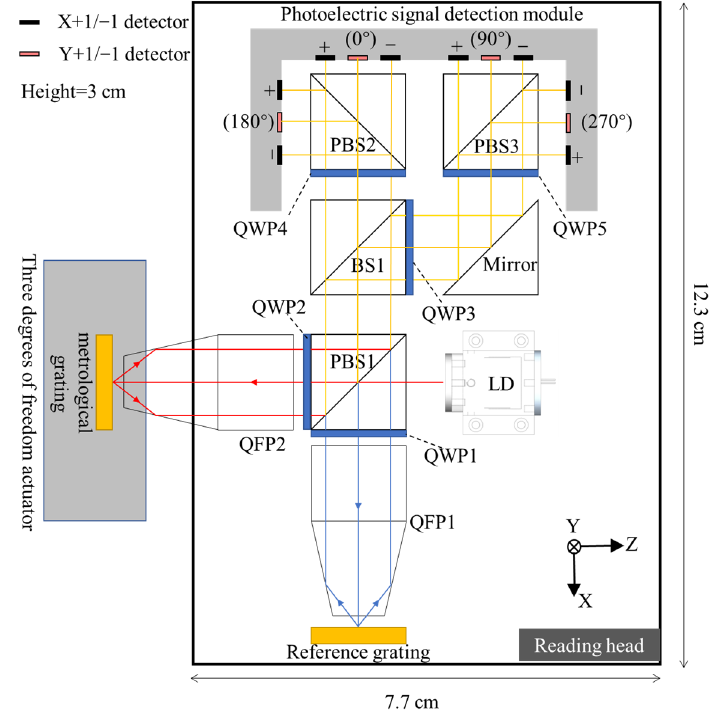
Figure 2. Schematic of the three-DOF reading head: (Beam Splitter (BS)). The phase change of the signal is used for measurement in three-DOF encoders. The After light synthesis, Doppler frequency shift effect causes phase changes in the diffracted light direction when the grating measurement moves along the X and Y directions. The principles in the two directions are the same. Therefore, this paper takes the X direction as an example. The light intensity is where the phase changes are Ω and Φ , corresponding to the displacements in the X and Z directions, respectively.